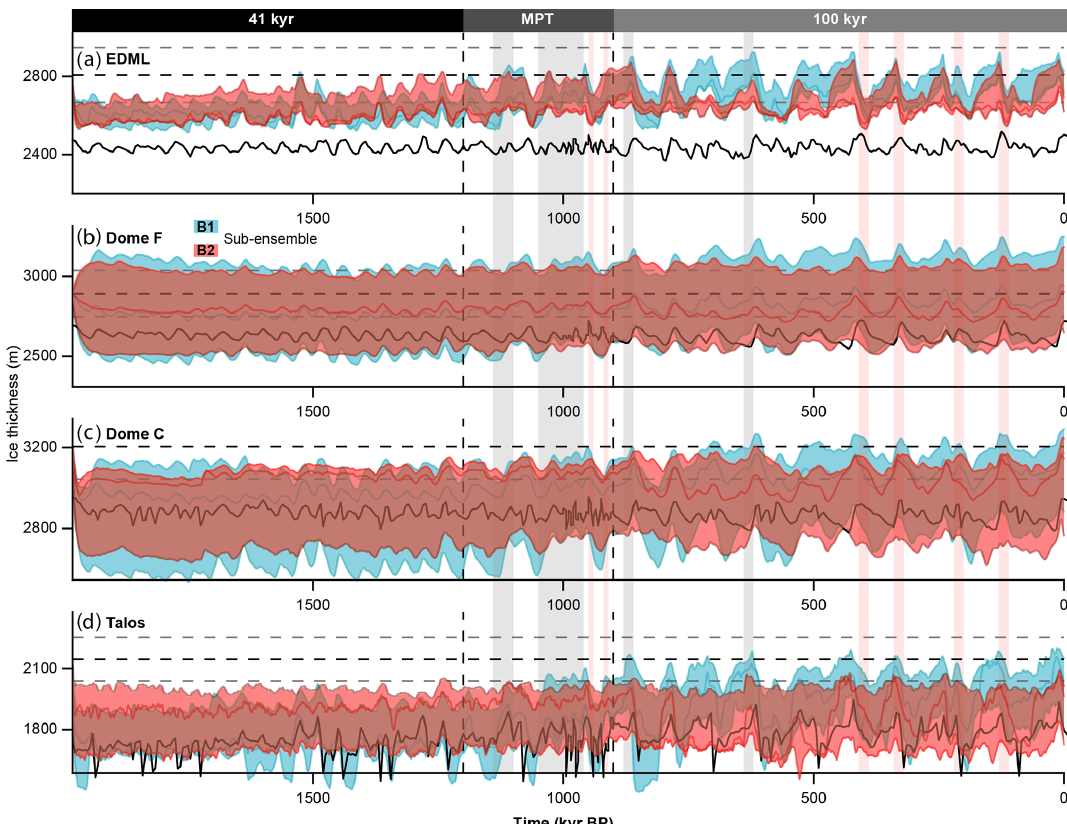
Figure 10. Same as Fig. 9 but for the four East Antarctic ice